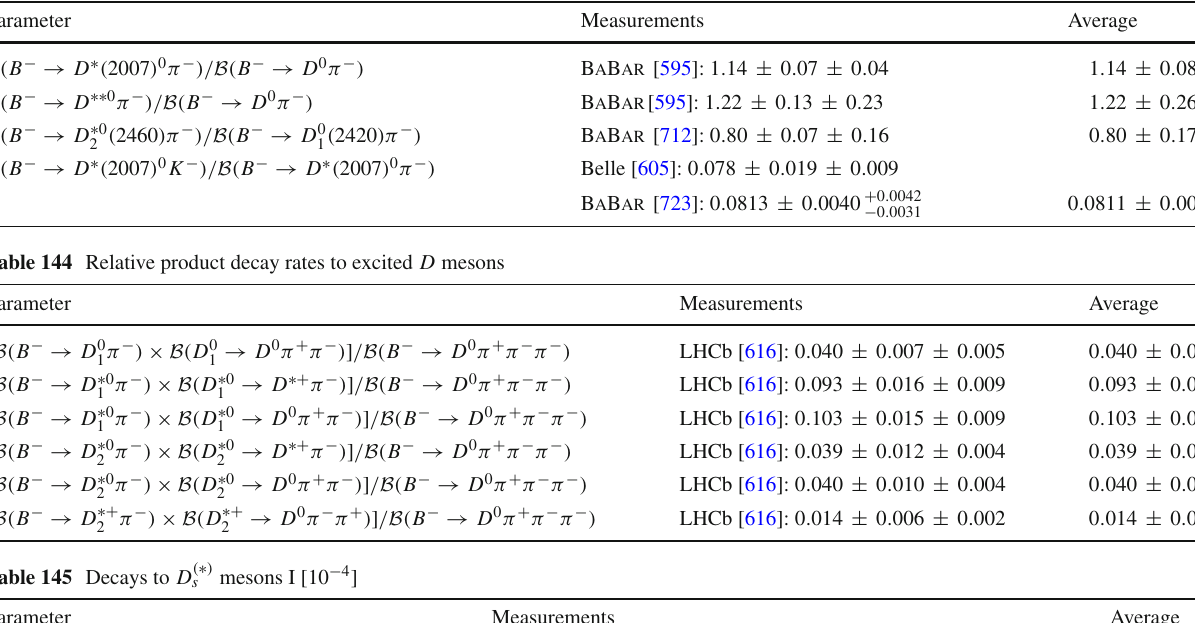
Table 145 Decays to D Parameter